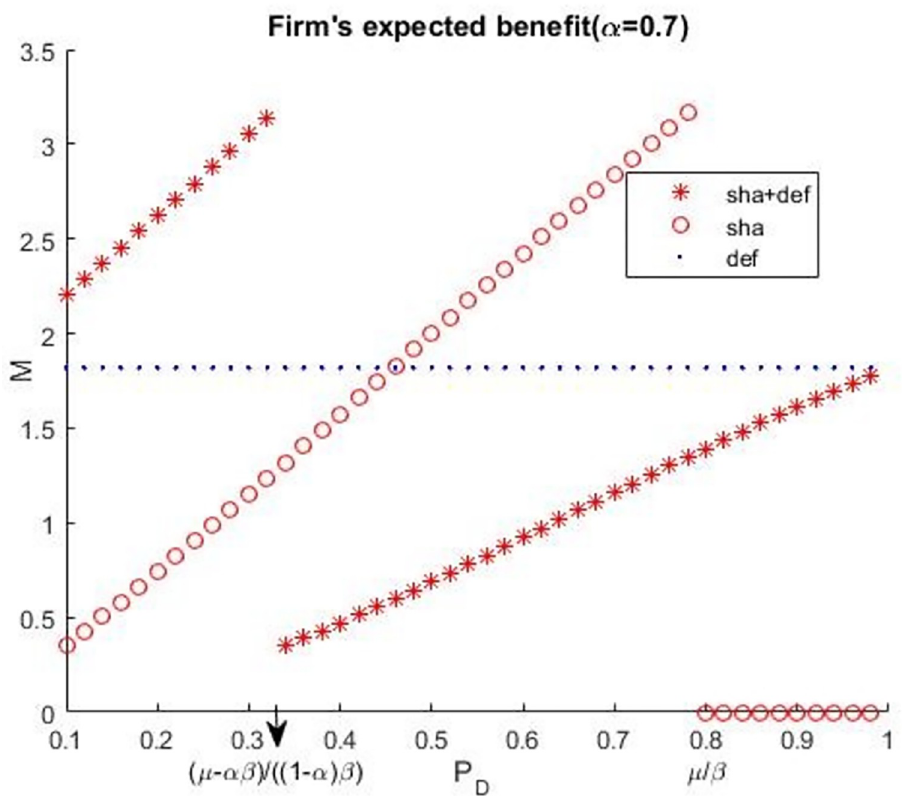
Fig 6. Firm’s expected benefits ( α =